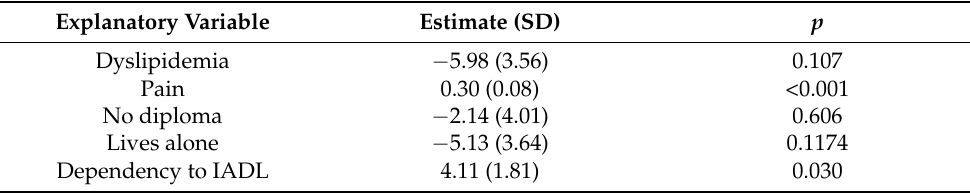
Table 3. Determinants of HRQoL: multivariable analysis (linear regression